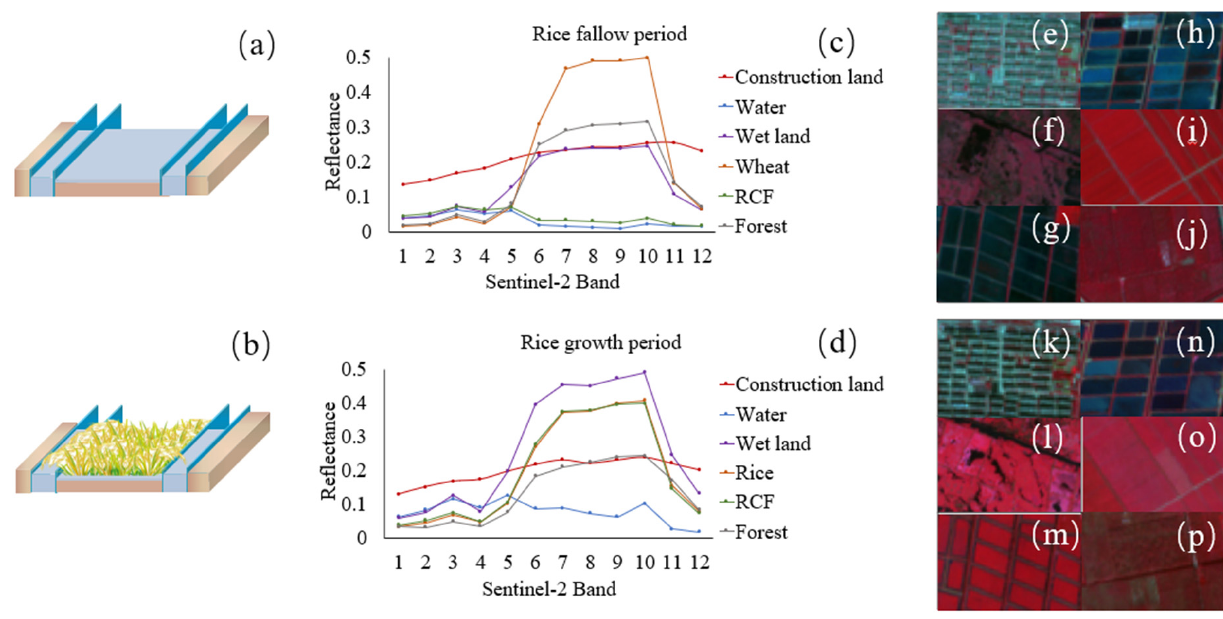
Figure 5. Comparison of the spectral and false-color images of different ground objects during two periods. ( a ) RCFs in the rice field fallow period; ( b ) RCFs in the rice growth period; ( c , d ) spectral curves of different ground objects based on Sentinel-2 images from the two periods; ( e – p ) false-color images of the different ground